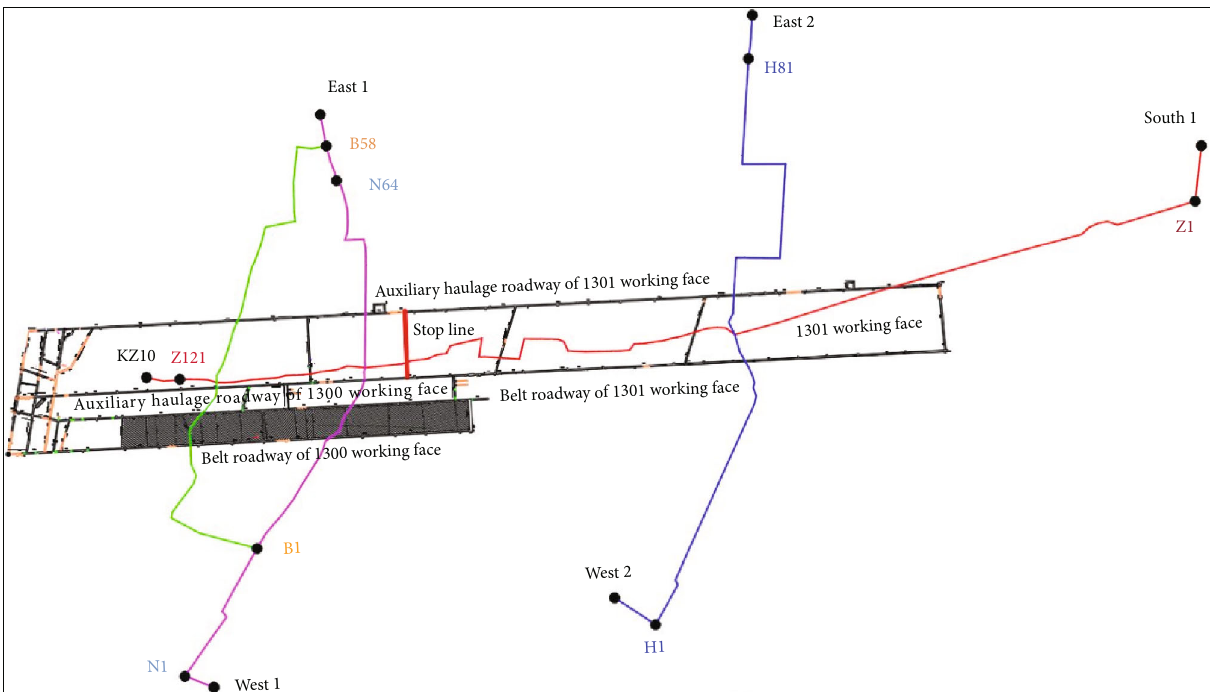
Figure 1: Relative position diagram of measuring line and working face.